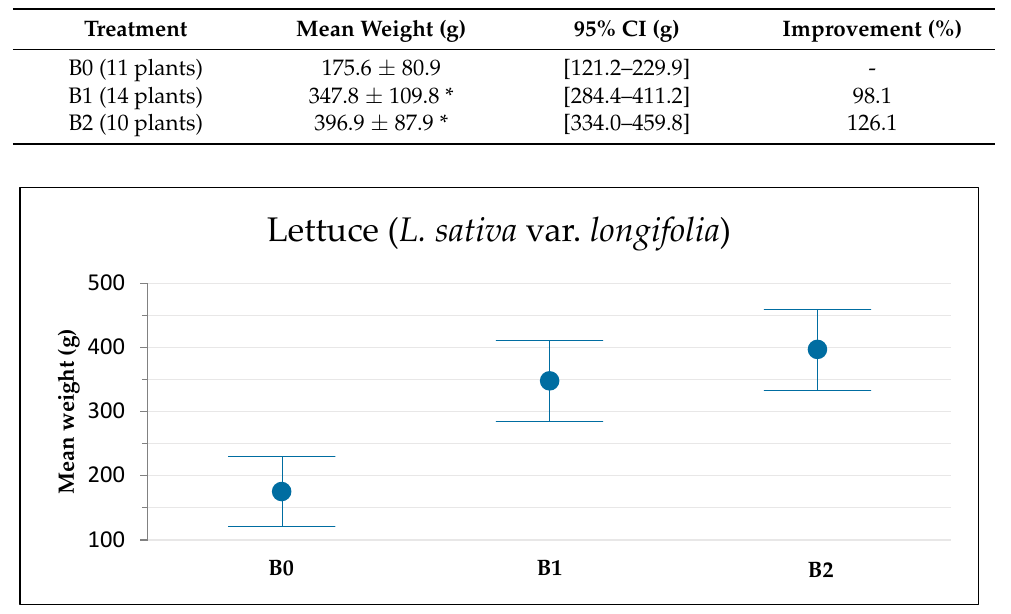
Table 4. Mean lettuce weight in each treatment, indicated as mean ± standard deviation, with 95% CI standing for confidence interval at p = 0.05. *: Significant difference p < 0.01.